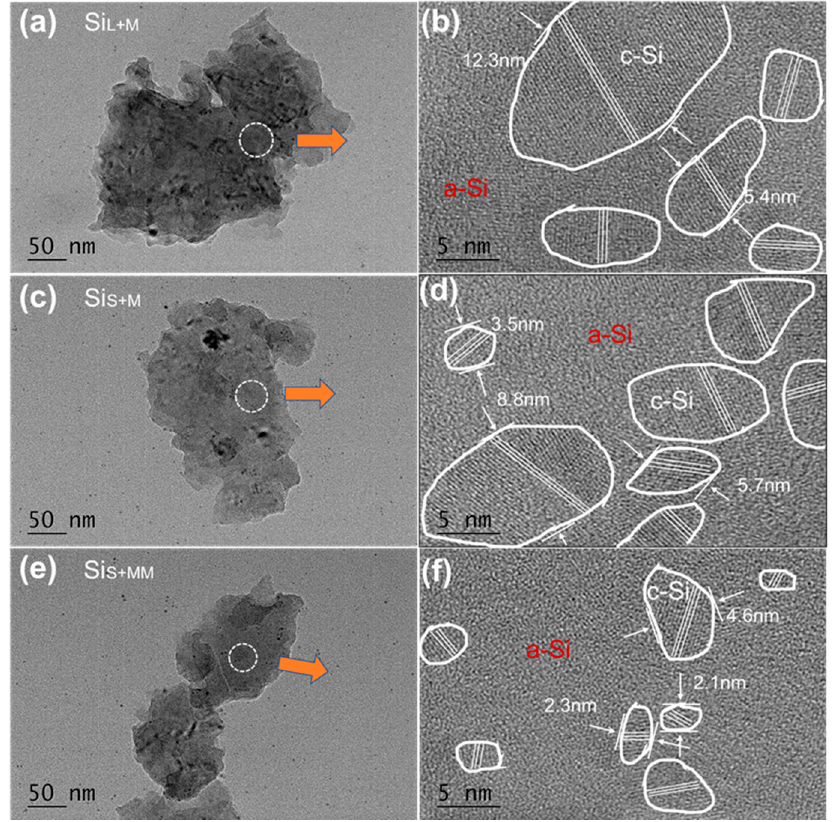
Figure 11. HRTEM images ( a , b ) of Si L+M and ( c , d ) of Si S+M , and ( e , f ) of Si S+MM